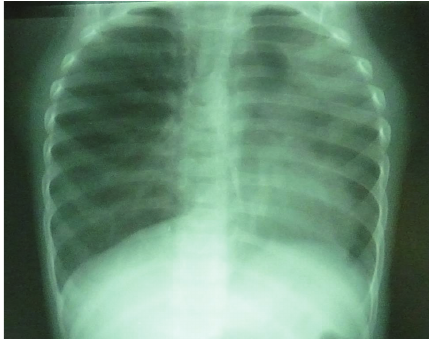
Figure 2: Chest CT scan showing collapse consolidation of upper left lobe with prominent air bronchograms (arrow). Note com- pensatory hyperinflation of the right upper lobe with shift of the mediastinum to the ipsilateral